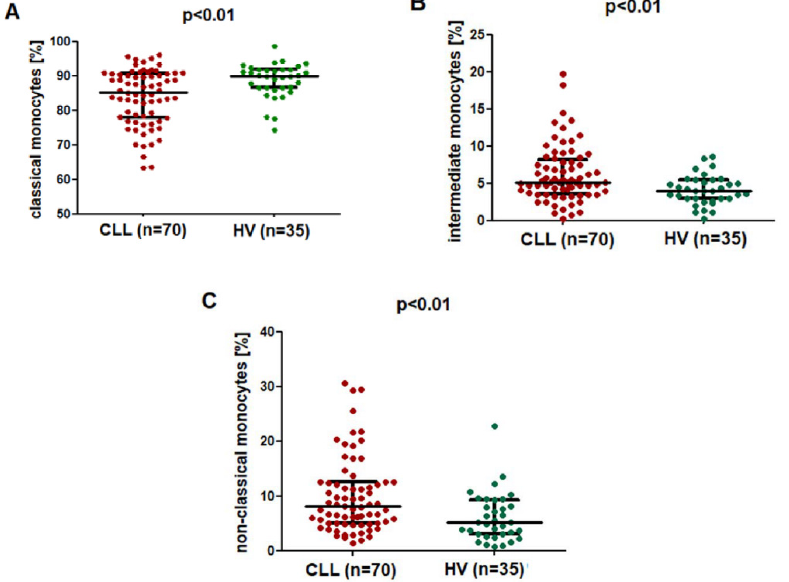
Figure 2. Comparison of the percentage of ( A ) classical CD14 + CD16 − SLAN − , ( B ) CD14 + CD16 + SLAN − intermediate monocytes and ( C ) non-classical CD14 dim CD16 + SLAN + monocytes in CLL patients and healthy volunteers. The solid line marks the median value, while the whiskers depict the interquartile range (IQR).